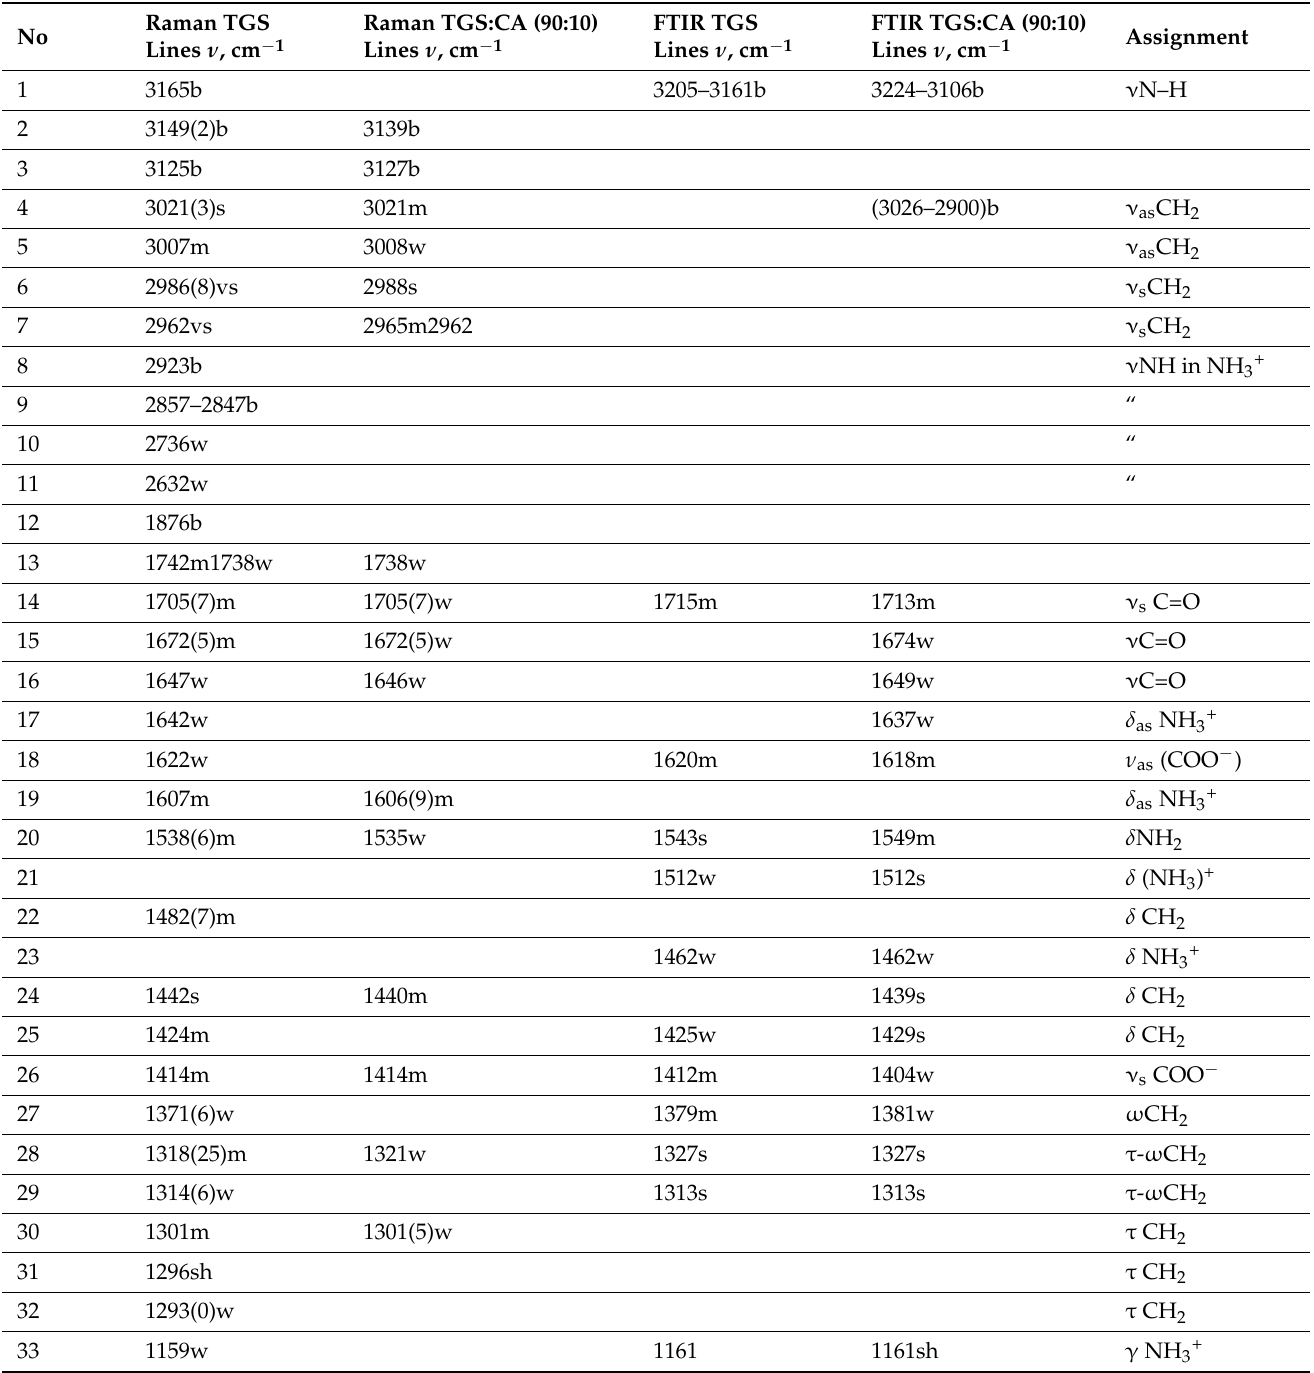
Table 7). Doping of TGS crystals with CA leads to the loss of translational symmetry in TGS:CA solid solutions. For this reason, one would expect a noticeable broadening of the lines in TGS:CA Raman spectrum [66]. However, no significant difference in line widths in Figure 5a,b is observed. Thus, a spatial disorder intrinsic to solid solutions does not significantly affect the Raman spectrum of TGS:CA crystals. It should be noted that the Raman scattering lines in TGS:CA are observed against the background of luminescence, which manifests itself in a wide spectral region and is absent in pure TGS. Table 7. Positions of lines ( ν , cm − 1 ) observed in Raman and FTIR spectra of TGS and TGS:CA (90:10) crystals and their